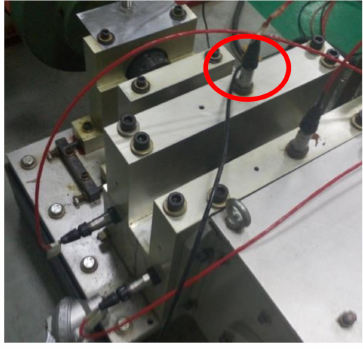
Figure 18. Vibration sensors installed on test rig.